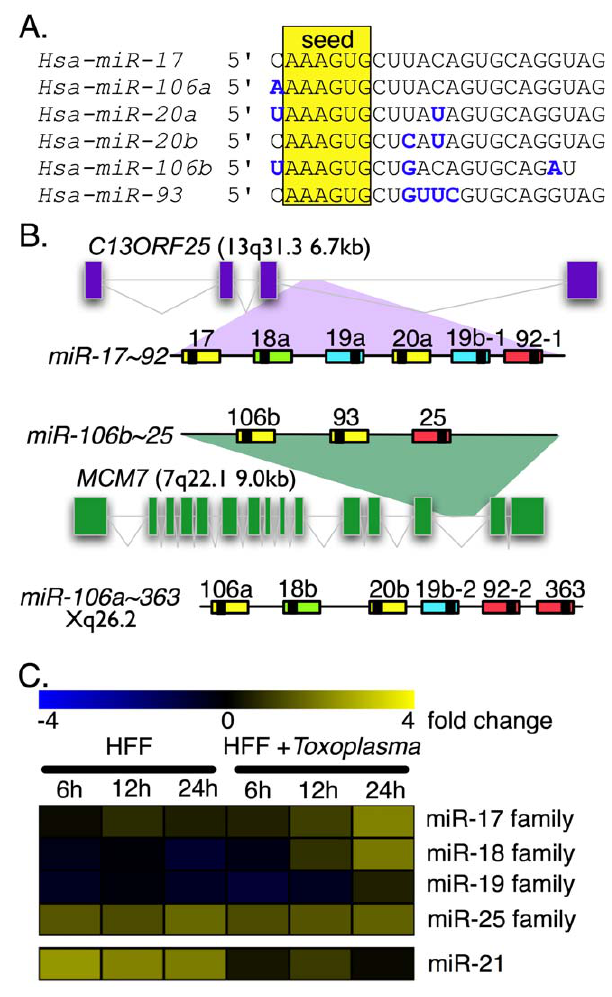
Figure 1. MiRNA microarray profiling reveals that Toxoplasma infection increases the levels of miR-17-, miR-18- and miR-19- family members. (A) Sequence alignment of miR-17 family members. The 6-nucleotide seed region that defines the miR-17 family is indicated in yellow. Nucleotide differences from the miR-17 sequence are shown in boldface blue type. (B) Genomic organization of the miR-17 , 92 , miR- 106b , 25 and miR-106a , 363 clusters. Colors of each miRNA indicate the miRNA family to which each belongs; miR-17=yellow; miR- 18=green; miR-19=blue; miR-25=red. miR-17 , 92 and miR-106b , 25 are encoded in the 3rd intron of C13ORF25 and the 13 th intron of MCM7, respectively; for these genes, exons are indicated as boxes, and introns are lines. (C) Microarray profiling of host miRNAs during Toxoplasma infection. From left to right, columns are from individual microarrays hybridized with RNA extracted from uninfected HFFs at 6, 12 or 24 hours and with RNA samples derived from HFFs infected with Toxoplasma at 6, 12 or 24 hours. The data were normalized with the default settings in the Stanford Microarray Database software package. The scale of the heat-map is presented as fold-change from the median value. The rows are the averaged data from all probes that are predicted to hybridize to members of the indicated miRNA families; these families represent all miRNAs encoded by the miR-17 , 92 , miR- 106a , 363 and miR-106b , 25 clusters. Shown for comparison is miR-21 which is a highly expressed miRNA in HFFs and is derived from an independent intergenic